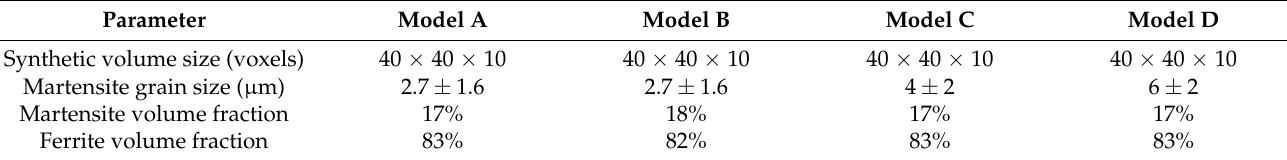
Figure 2. Top surfaces of 3D RVE models of the dual-phase steels, where the black particles represent the martensite phase inside the grey ferrite matrix. Table 2. The projected RVEs used in the study with ferrite grain size 8.4 ± 6.1 µm for all the RVEs.